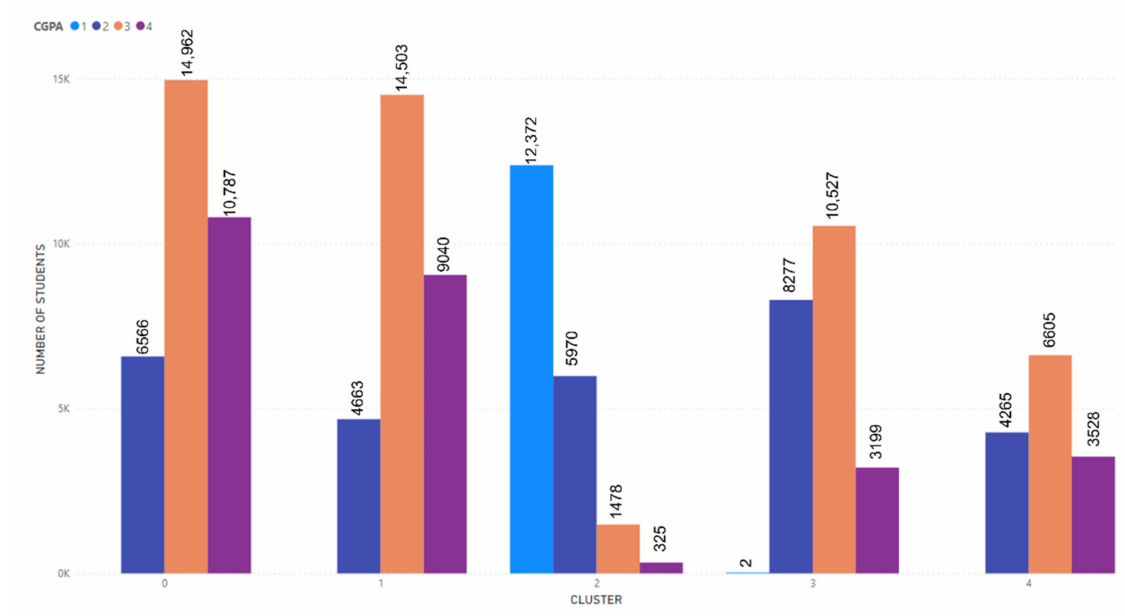
Figure 7. Clustering results of students’